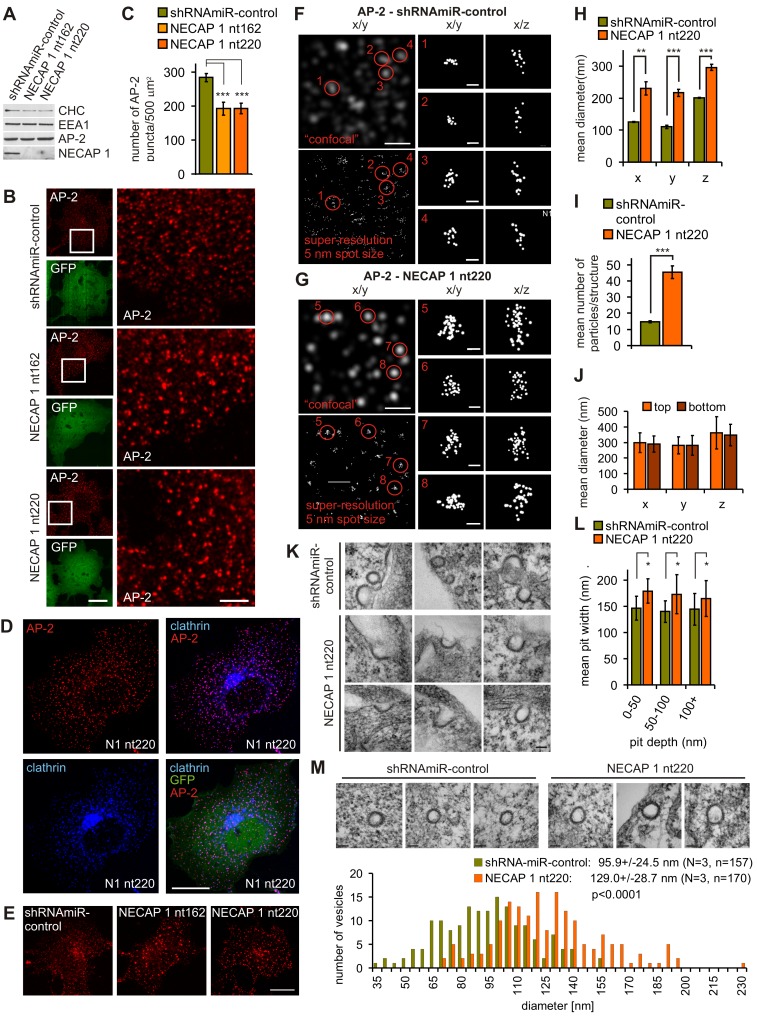
The number of vesicle formation sites and vesicle size are altered upon NECAP 1 KD.(A) Equal protein amounts of lysates from COS-7 cells transduced with control virus (shRNAmiR-control) or viruses to KD NECAP 1 (NECAP 1 nt162, NECAP 1 nt220) were processed by Western blot for the indicated proteins, CHC, clathrin heavy chain; EEA1, early endosomal antigen 1. (B) Immunofluorescence analysis of endogenous AP-2 in control and NECAP 1 KD COS-7 cells. The large panel is a magnification of the area boxed in the small AP-2 panel. The bar represents 20 µm in the small and 5 µm in large panels. (C) Quantification of (B). Repeated measures one-way ANOVA followed by Bonferroni's Multiple Comparison Test revealed a significant difference between control and KD cells, ***p<0.0001, N = 4. (D) NECAP 1 KD COS-7 cells were processed for immunofluorescence to reveal endogenous AP-2 and clathrin light chains (clathrin). The bar represents 20 µm. In (B and D), GFP is expressed as part of the viral expression cassette to verify transduction. (E) Distribution of Cy3-labeled transferrin endocytosed for 1 min in control (shRNAmiR-control) and NECAP 1 KD (NECAP 1 nt162 and NECAP 1 nt220) COS-7 cells. The bar represents 20 µm. (F and G) 3D superresolution analysis of AP-2-labeled vesicle formation sites in control (F) and NECAP 1 KD cells (G). The large panels show a 4 µm2 area with biplane signals rendered to a 250 nm particle size (“confocal”) to illustrate a traditional microscope image, and rendered to a 5 nm particle size (superresolution). The small panels show individual structures from the large panels as indicated in x/y and x/z orientation with signals rendered to a 5 nm particle size. The 5 nm spot size exceeds the localization precision of each point but shows the distribution and numbers of localizations. The scale bar represents 1 µm in the large and 100 nm in the small panels. (H) Quantification of the x, y, and z diameters of deeply invaginated CCPs in control and NECAP 1 KD cells. Unpaired two-tailed t tests revealed significant differences in size for all three dimensions, x-axis, **p = 0.0038; y-axis, ***p<0.0001; z-axis, ***p<0.0001; shRNAmiR-control: four cells, 40 vesicle formation sites; NECAP 1 nt 220: six cells, 60 vesicle formation sites. (I) Quantification of the number of AP-2 signals detected per vesicle formation site. An unpaired two-tailed t test revealed a significant difference, ***p = 0.0002; shRNAmiR-control: four cells, 40 vesicle formation sites; NECAP 1 nt 220: six cells, 60 vesicle formation sites. (J) Quantification of the x, y, and z diameters of deeply invaginated vesicle formation sites at the bottom (cell surface contacting the cover slip) or top (cell surface facing the culture medium) of NECAP 1 KD cells. Unpaired two-tailed t tests revealed no significant differences in size for all three dimensions, each location: three cells, 23 vesicle formation sites. (K and L) Size analysis of CCPs in control and NECAP 1 KD COS-7 cells measuring the width of CCPs detected by EM. (K) The electron micrographs show representative examples of structures found in control and KD cells. The bar equals 100 nm. (L) The bar graph shows the average width of CCPs binned for pits depths of 0–50 nm, 50–100 nm, and 100+ nm in control and NECAP 1 KD cells. Statistical analysis using a two-tailed Mann Whitney test revealed a significant difference in size between the two populations in each bin, 0–50 nm, *p = 0.0286; 50–100 nm, *p = 0.0370; 100+, *p = 0.0280. (M) Size analysis of CCVs in control and NECAP 1 KD COS-7 cells measuring the membrane-to-membrane diameter of CCVs detected by EM. The electron micrographs show representative examples of structures found in control and KD cells (bars equal 100 nm), and the bar graph shows the size distribution within the whole population of vesicles analyzed in each condition. Statistical analysis using a two-tailed unpaired t test revealed a significant difference in size between the two populations, ***p<0.0001, N = 3.